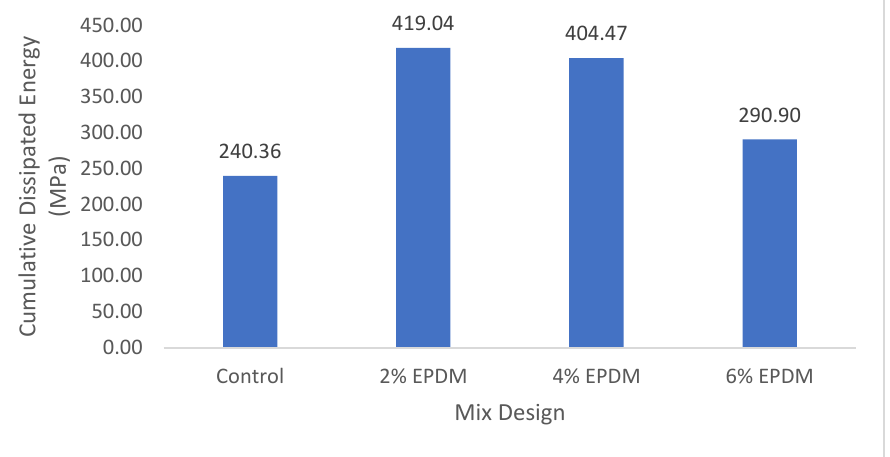
Figure 10. Cumulative dissipated energy results.